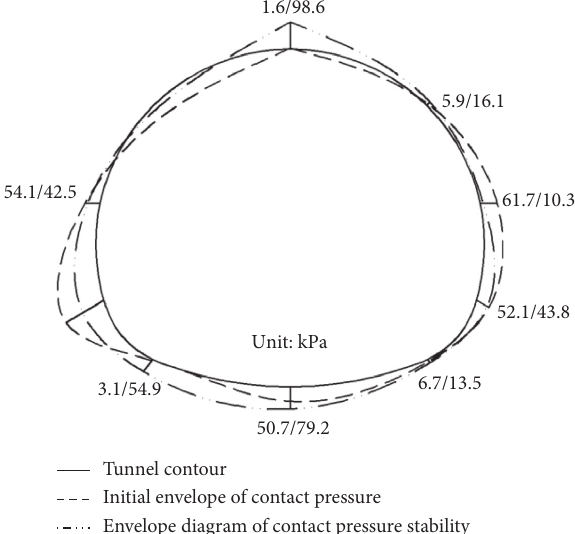
Figure 14: Envelope diagram of early third tunnel DK-190 +645 mileage contact